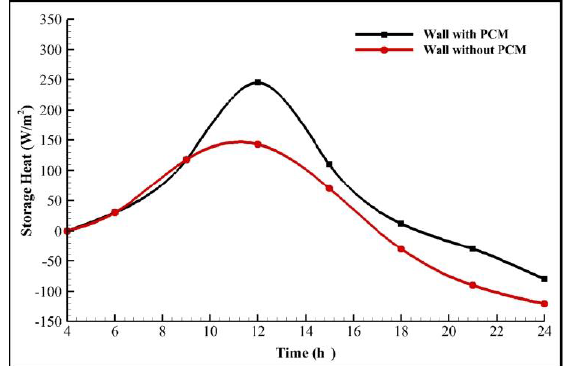
Figure 11. Amount of heat storage of the non ‐ PCM ‐ and PCM ‐ treated south walls.